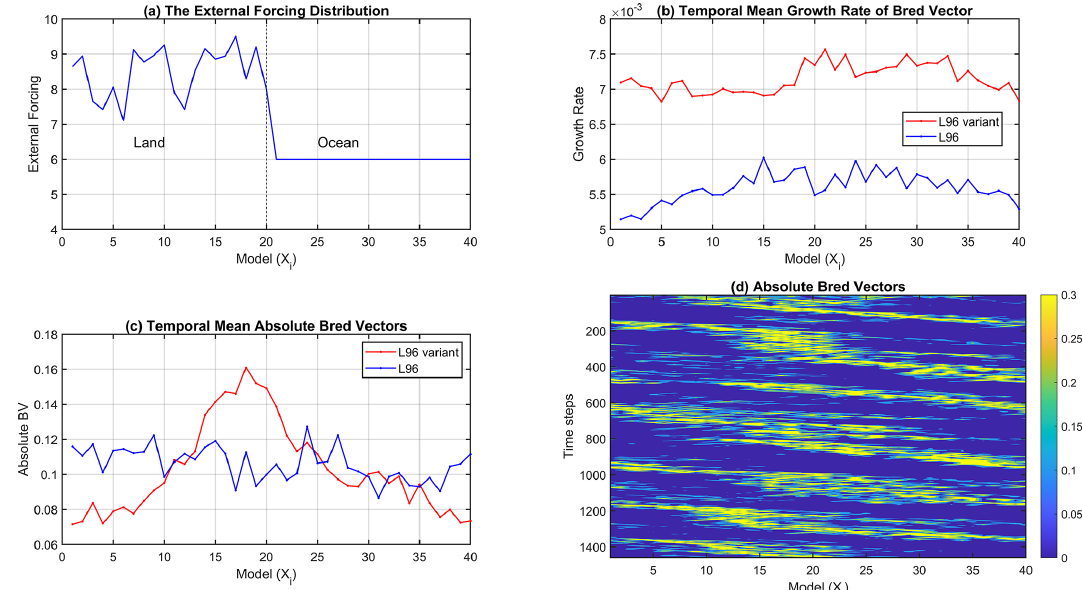
Figure 1. (a) The external forcing ( F + f i ) used in the variant L96 model, the temporal mean of (b) the growth rate and (c) absolute bred vectors, and (d) the time evolution of the absolute bred vectors for the variant L96 models. The breeding rescale cycle is 4 steps ( n = 4, (cid:49)t = 0 . 0125), which equals our DA window length. The breeding rescale amplitude is